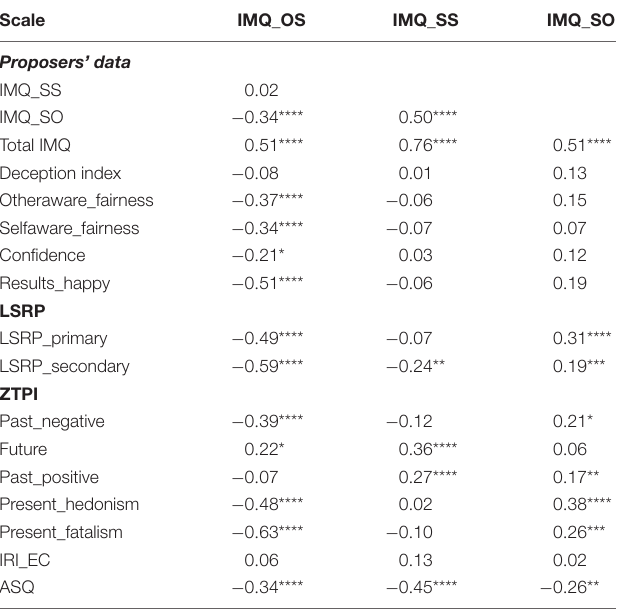
TABLE 5 | Correlations between questionnaires and behavioral index in Sample